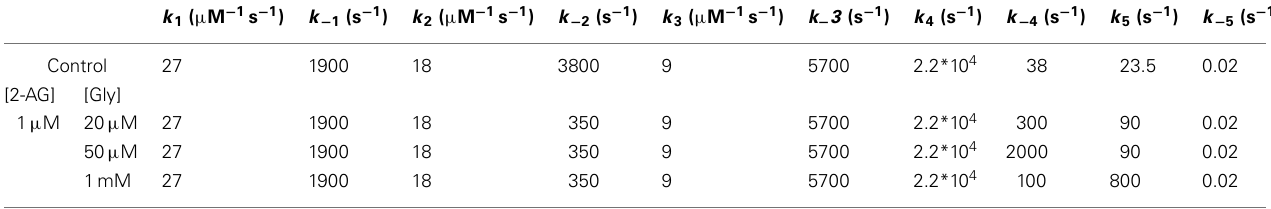
TableA1 | The rate constant values in control conditions and in the presence of 2-AG.